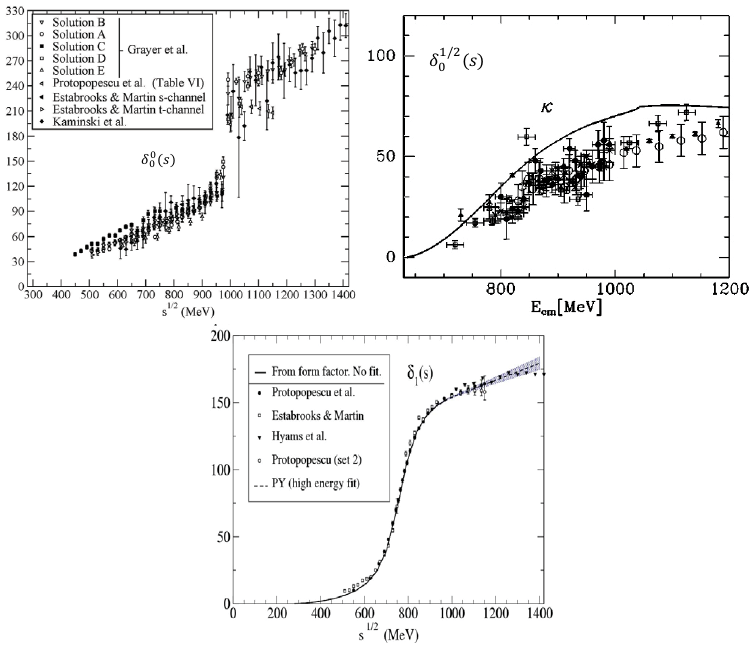
Figure 3. Data on meson-meson scattering partial-wave phase-shifts δ I the angular momentum. Up-Left: ππ → ππ in the scalar-isoscalar channel. Up-right: π K → π K in the scalar-isospin 1 / 2 channel. Note in both cases the inconsistencies within di ff erent data sets, but also within the same experiment. Bottom: ππ → ππ in the vector-isovector channel. Figures taken from [2], [5] and [2], respectively, see references